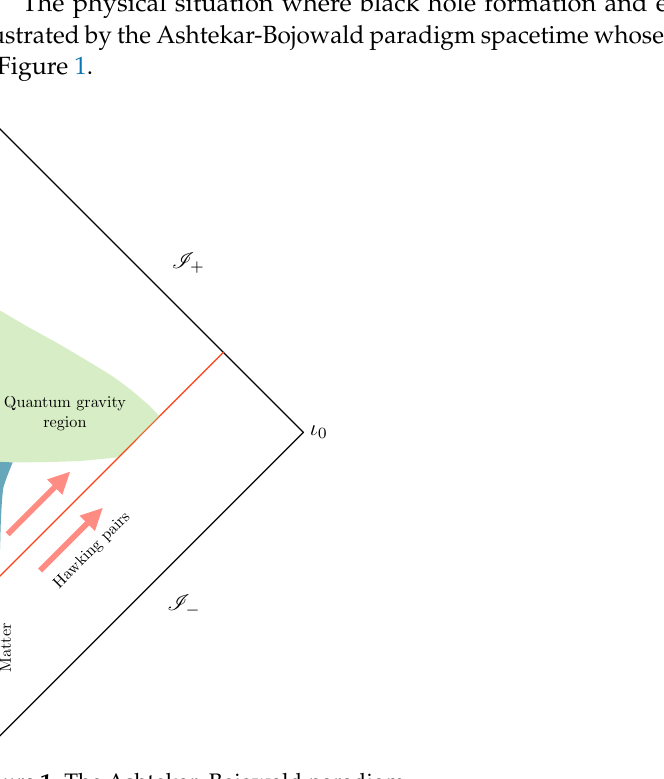
Figure 1. The Ashtekar–Bojowald